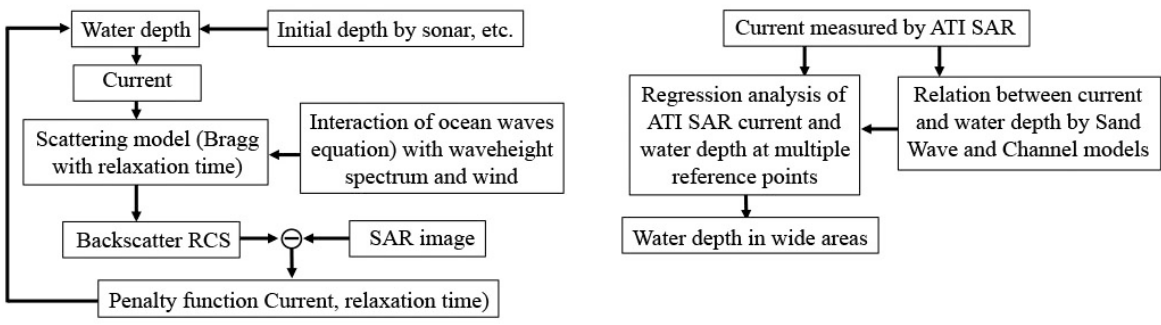
Figure 24. Flowchart for the bathymetry measurements by the RCS–based method ( left ) and ATI SAR-based approach ( right ).